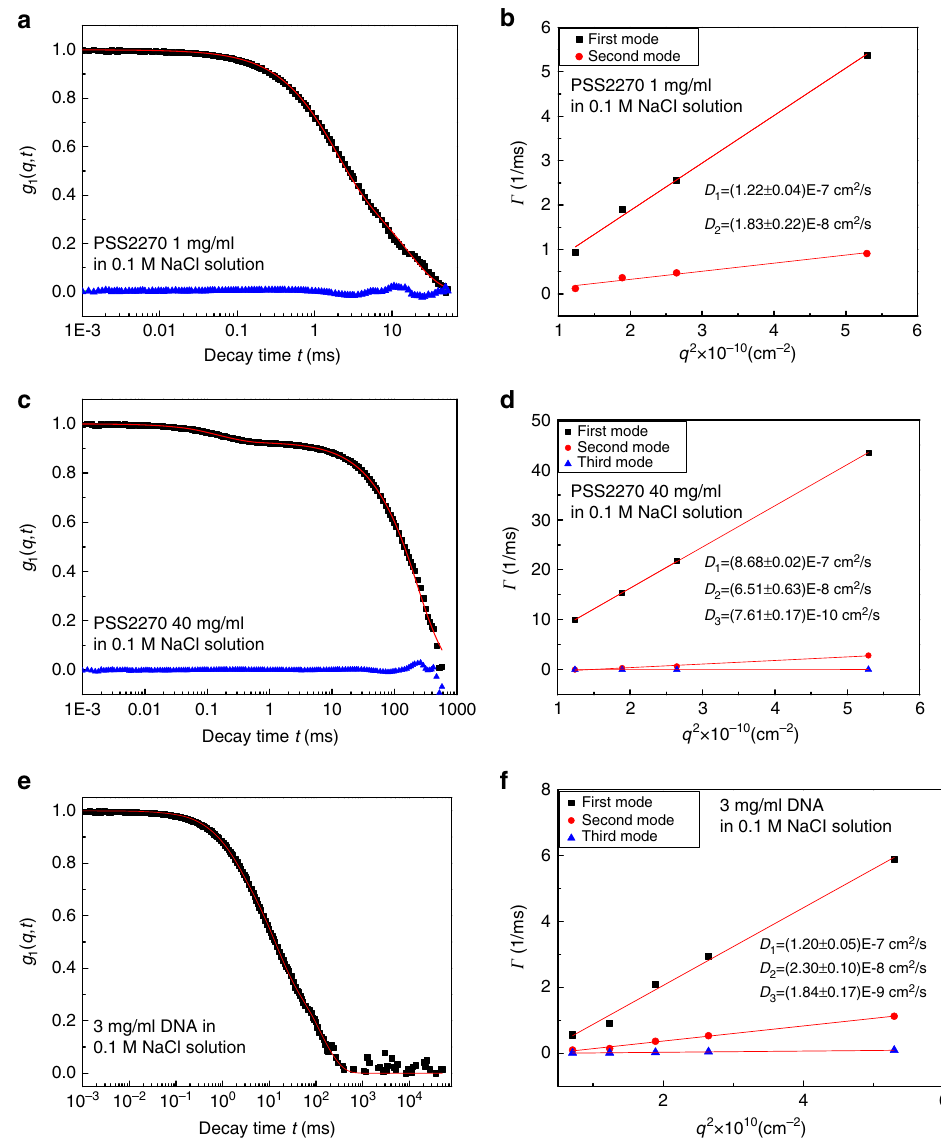
Fig. 4 Dynamics of polyelectrolytes in solutions. a , c , e Normalized fi eld-correlation function g 1 ( q , t ) at scattering angle 30° for ( a ) PSS2270 solution at C = 1 mg/mL, ( c ) PSS2270 solution at C = 40 mg/mL, ( e ) DNA solution at C = 3 mg/mL. The blue triangles are the residuals between the fi tting curve and the original data. b , d , f Corresponding q 2 dependence of the relaxation rates Γ for ( b ) PSS2270 solution at C = 1 mg/mL, ( d ) PSS2270 solution at C = 40 mg/mL, ( f ) DNA solution at C = 3 mg/mL, respectively. All samples are with 0.1 M